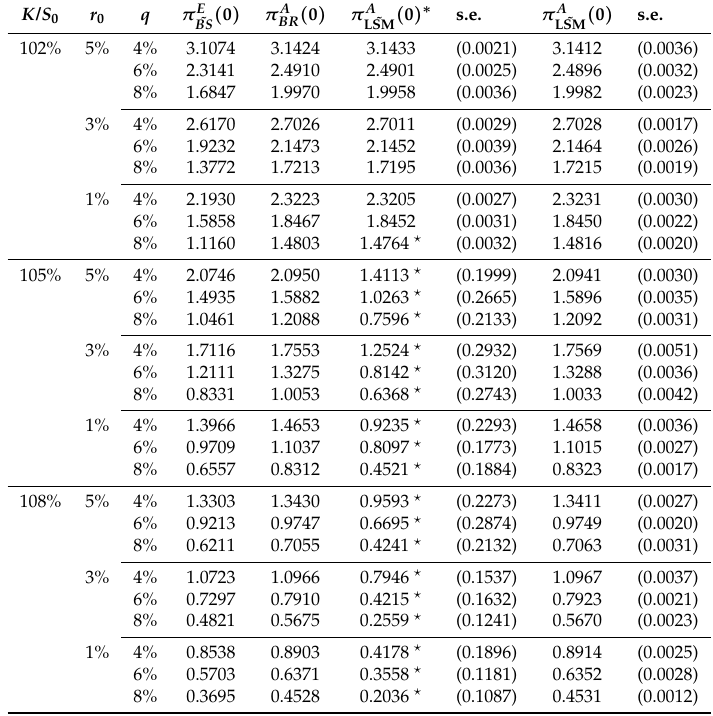
Table 4. Numerical results, Vasicek model. S 0 = 100, T = 1, σ = 10%, σ r = 1%, κ = 1, θ =